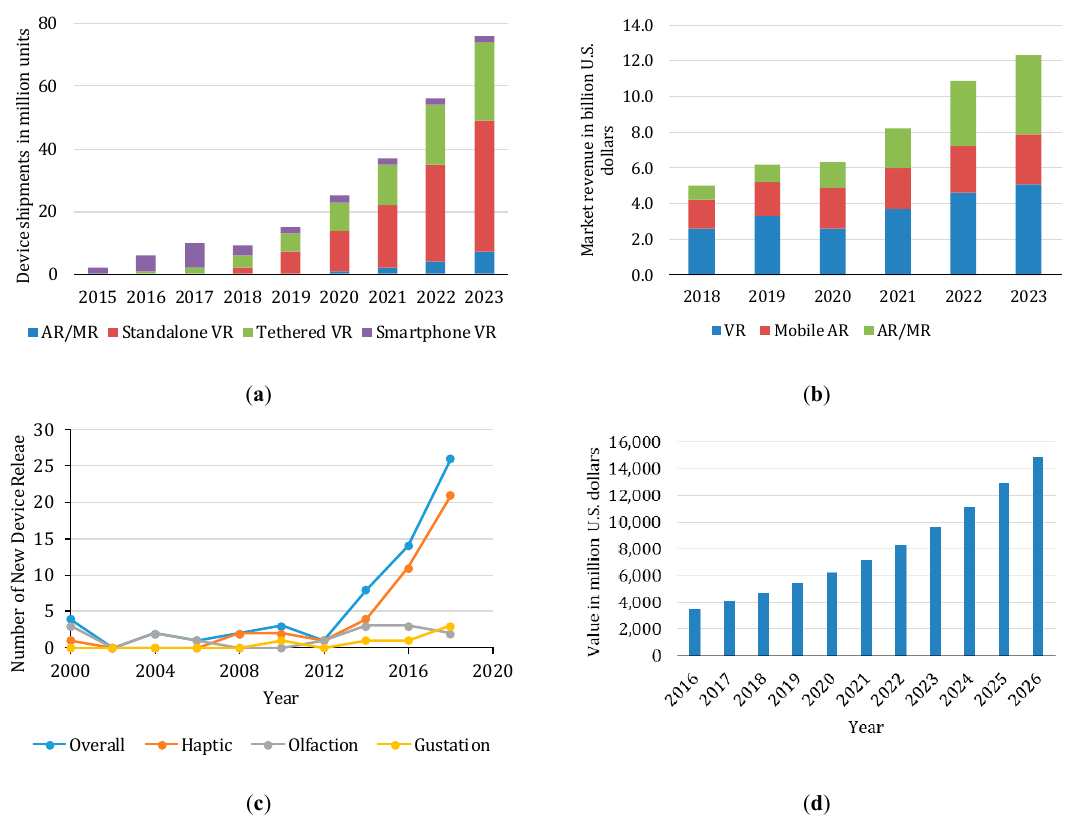
Figure 5. Trends of the immersive technology and market: ( a ) immersive device shipments worldwide from 2015 to 2023, by product type; ( b ) immersive technology consumer market revenue worldwide from 2018 to 2021; ( c ) a number of new virtual reality sensory device releases along with years, by category, where all the figures before 2000 are aggregated to 2000; ( d ) value of the haptic technology market in the Asia-Pacific region from 2016 to 2017.